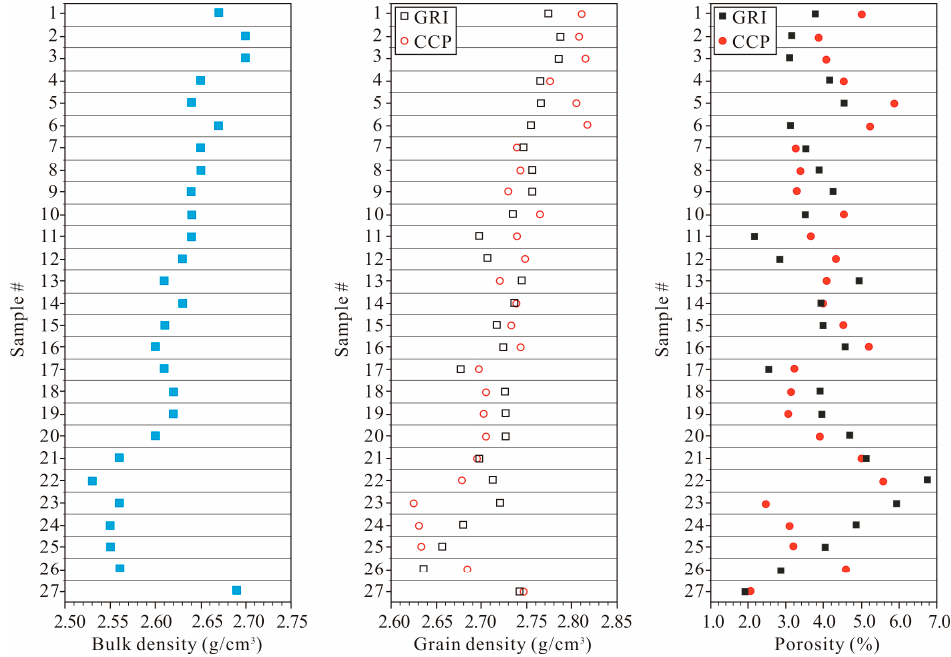
Figure 2. The bulk density, grain density and porosity values of the samples using the composition content porosimetry (CCP) and the Gas Research Institute (GRI)